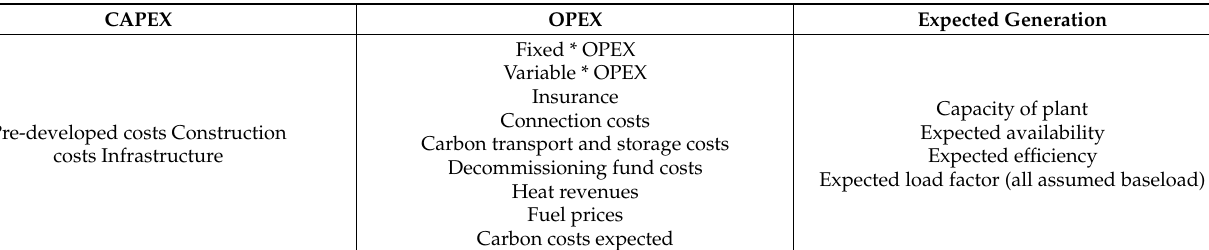
Table 1. BEIS’s LCOE